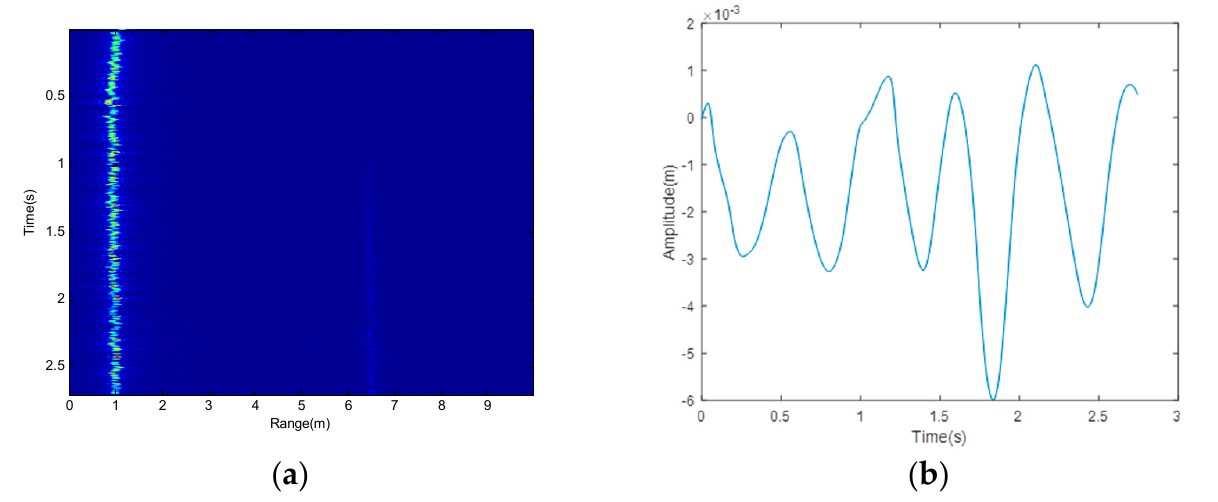
Figure 5. ( a ) One − dimensional range result of the WSAW and sea wave interference; ( b ) range change result.